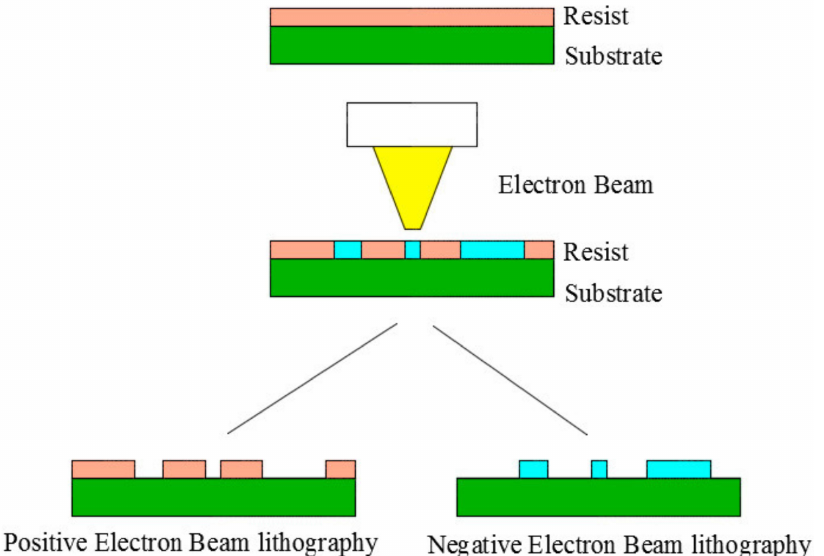
Figure 5. The principle of electron beam lithography. Adapted from [101], under the terms of the Creative Commons CC BY